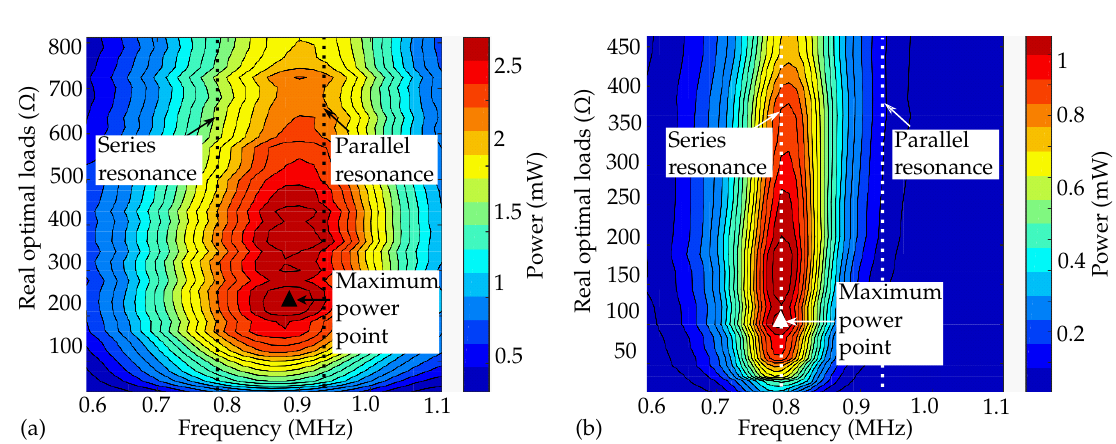
Figure 8. Measured power with real electric loads at the receiver with ( a ) aluminium as the transmitting medium and ( b ) POM as the transmitting